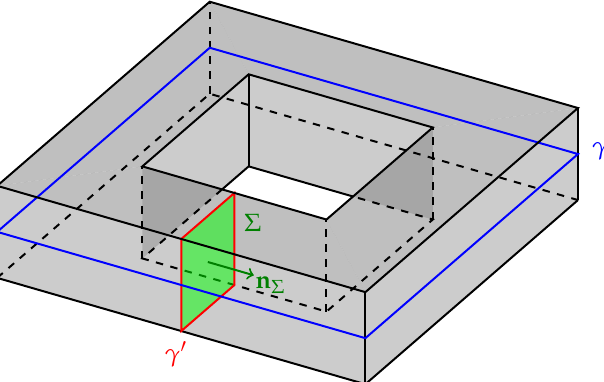
Figure 2. Torus domain with two generating cycles γ and γ (cid:48)